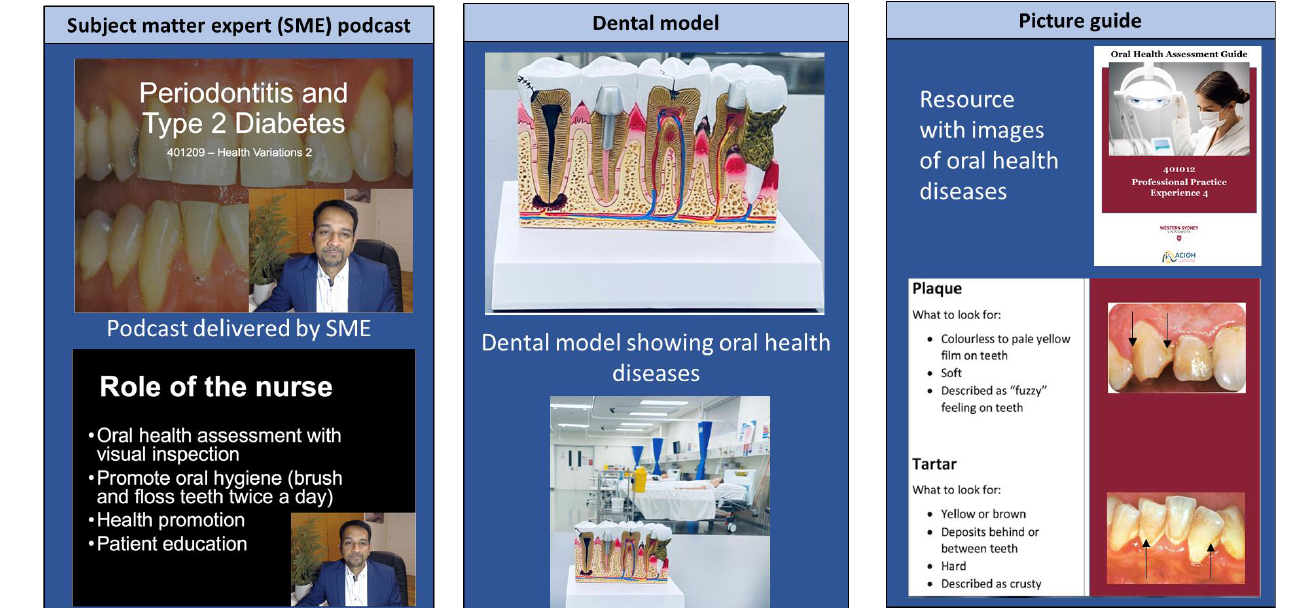
Figure 2. Example learning